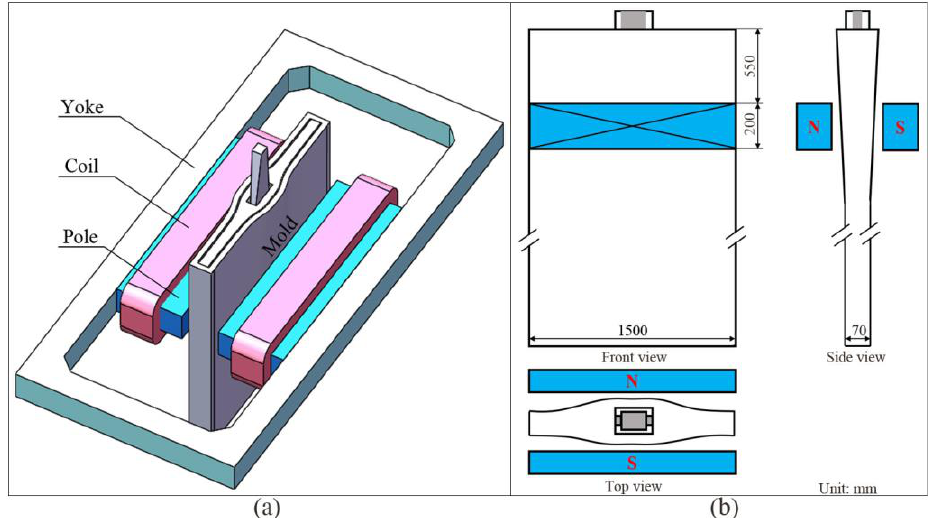
Figure 1. Schematic diagram of ruler EMBr device: ( a ) the geometric model of the ruler EMBr device and ( b ) the dimensions of the ruler EMBr device.